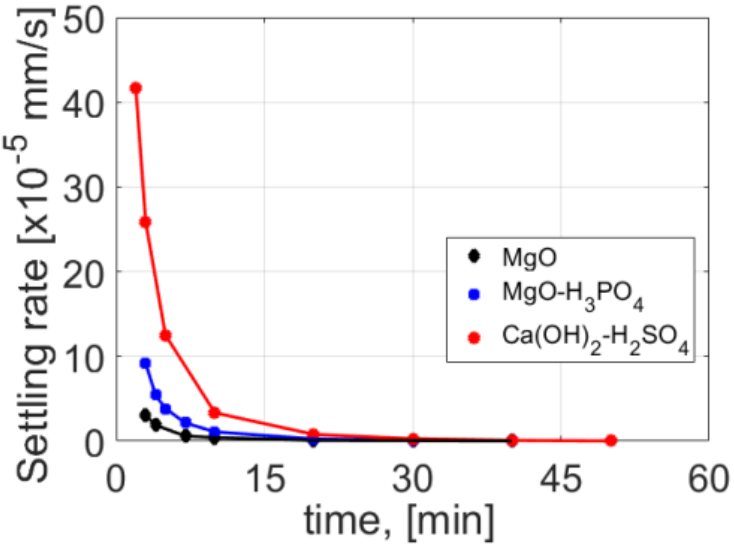
Figure 7. Average settling rate of suspended particles after sedimentation using MgO, MgO-H 3 PO 4 , and Ca(OH) 2 -H 2 SO 4 .